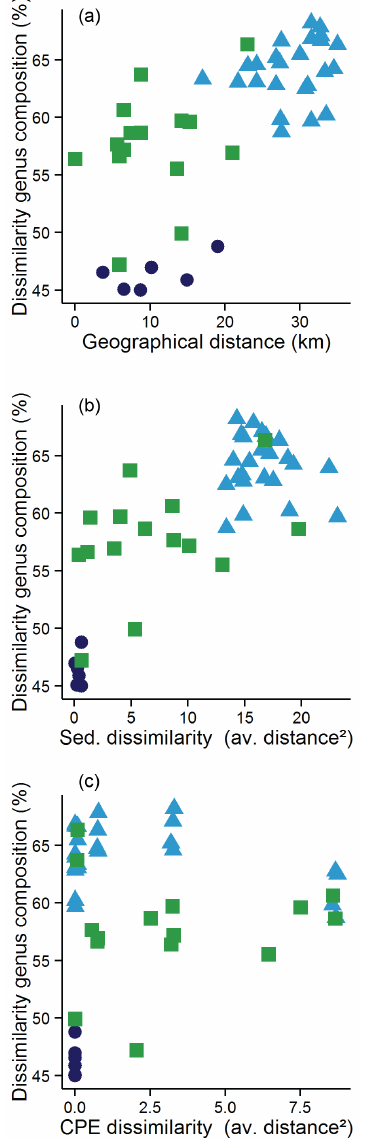
Figure 5. Dissimilarity values in nematode genus composition among geographical distance (a) , sediment composition (b) , and chloroplastic pigment equivalents (CPE). Green squares represent dissimilarities between shallow sites, dark blue circles between deep sites, and light blue triangles show dissimilarities between shallow and